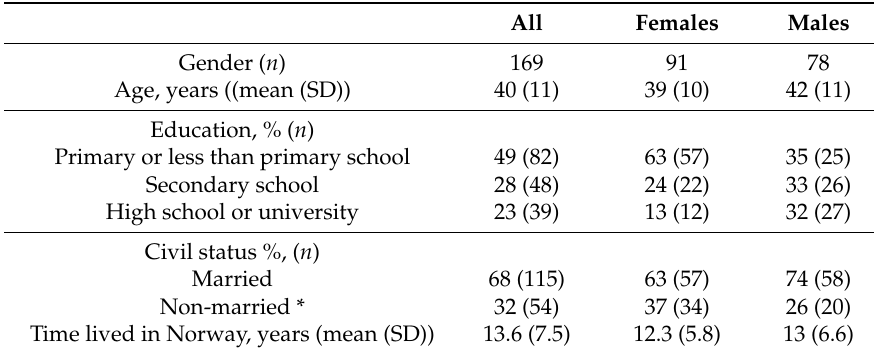
Table 1. Characteristics of the study